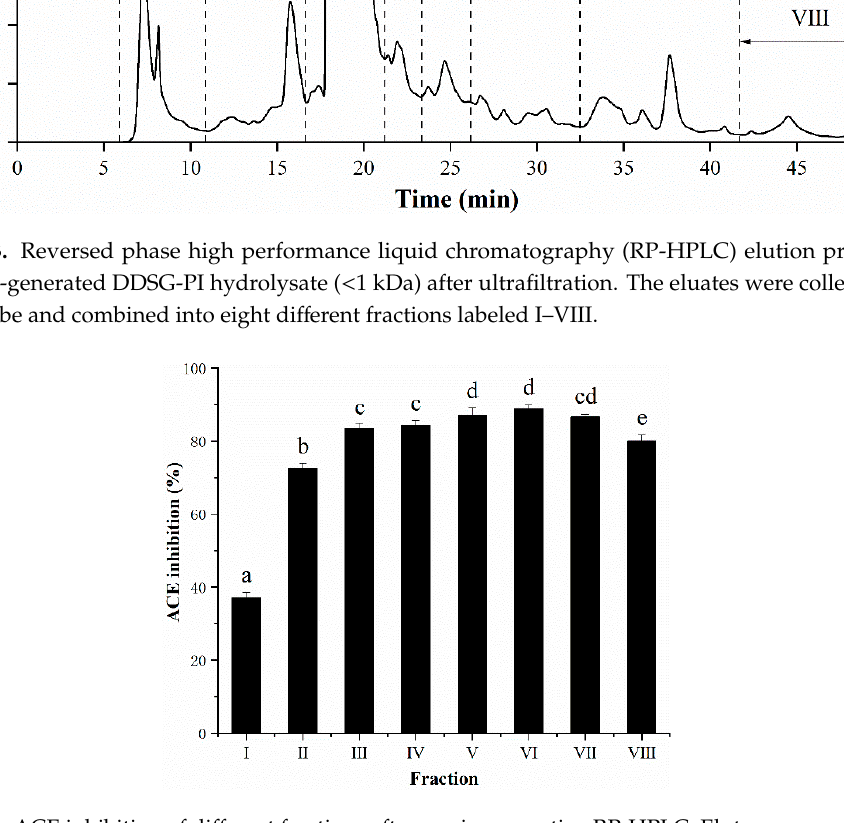
Figure 4. ACE inhibition of different fractions after semi-preparative RP-HPLC. Elutes were combined into eight fractions and analyzed for ACE inhibitory activity at a final concentration of 0.5 mg/mL (based on DW). All data were presented as means ± SD ( n = 3). Different letters indicated the significant difference at p < 0.05.